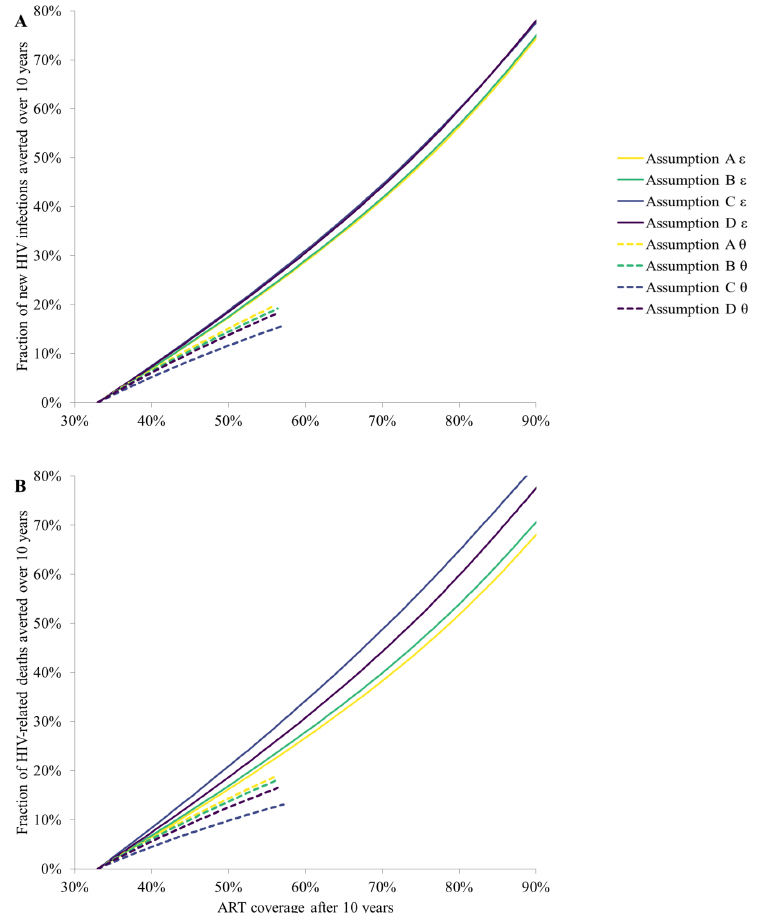
decreasing ART dropout rate ( θ , dashed lines) to obtain final ART coverage